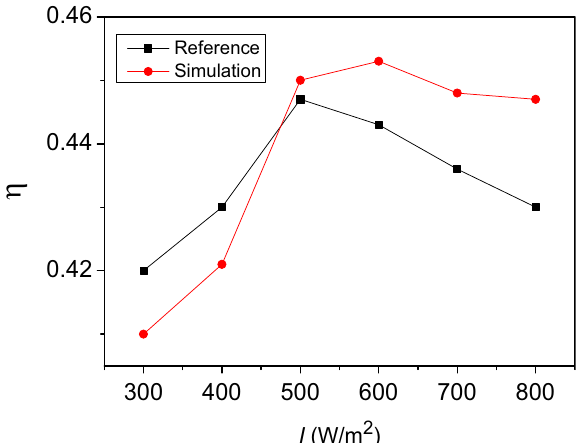
Figure 3. Comparison of thermal efficiency.